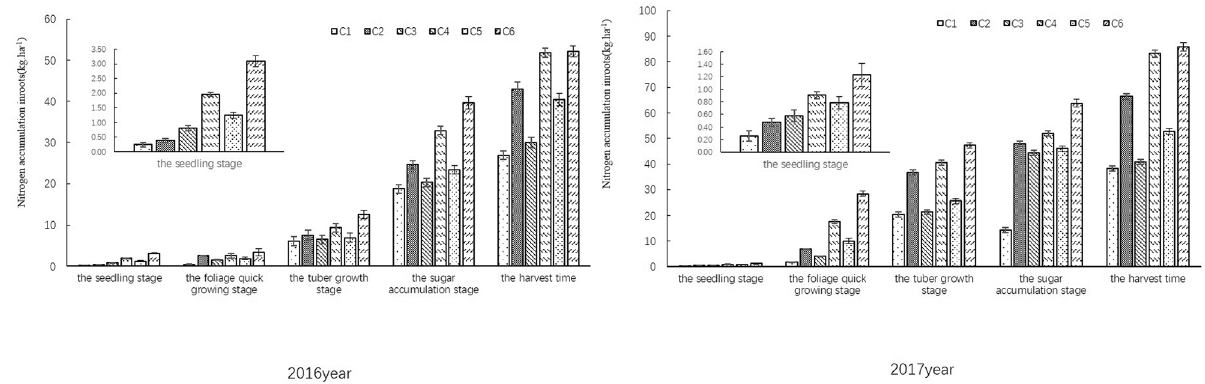
Figure 5. Effect of limited irrigation on nitrogen accumulation rate in the roots of sugar beet in 2016 and 2017.